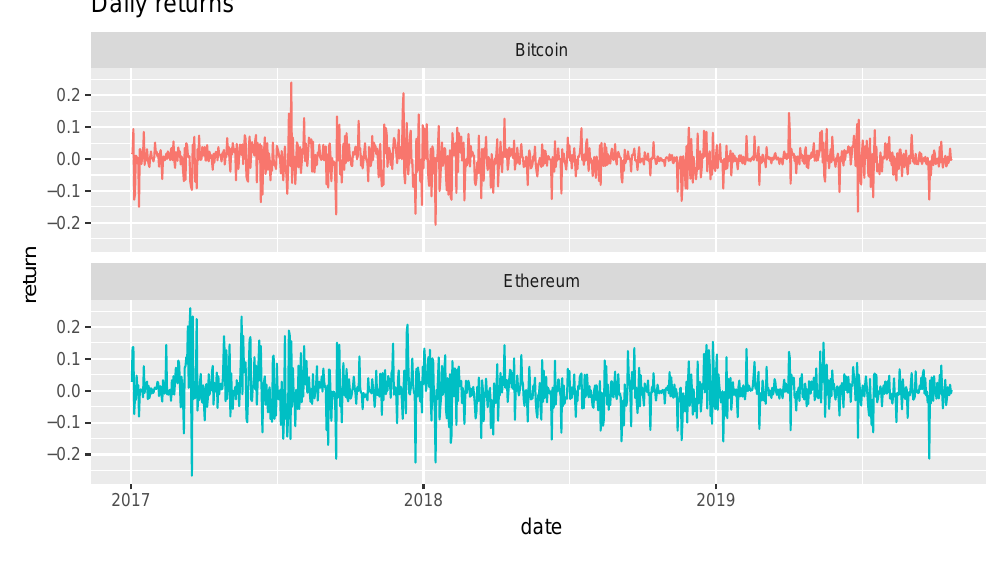
Figure 3: Time series of Bitcoin and Ethereum daily returns